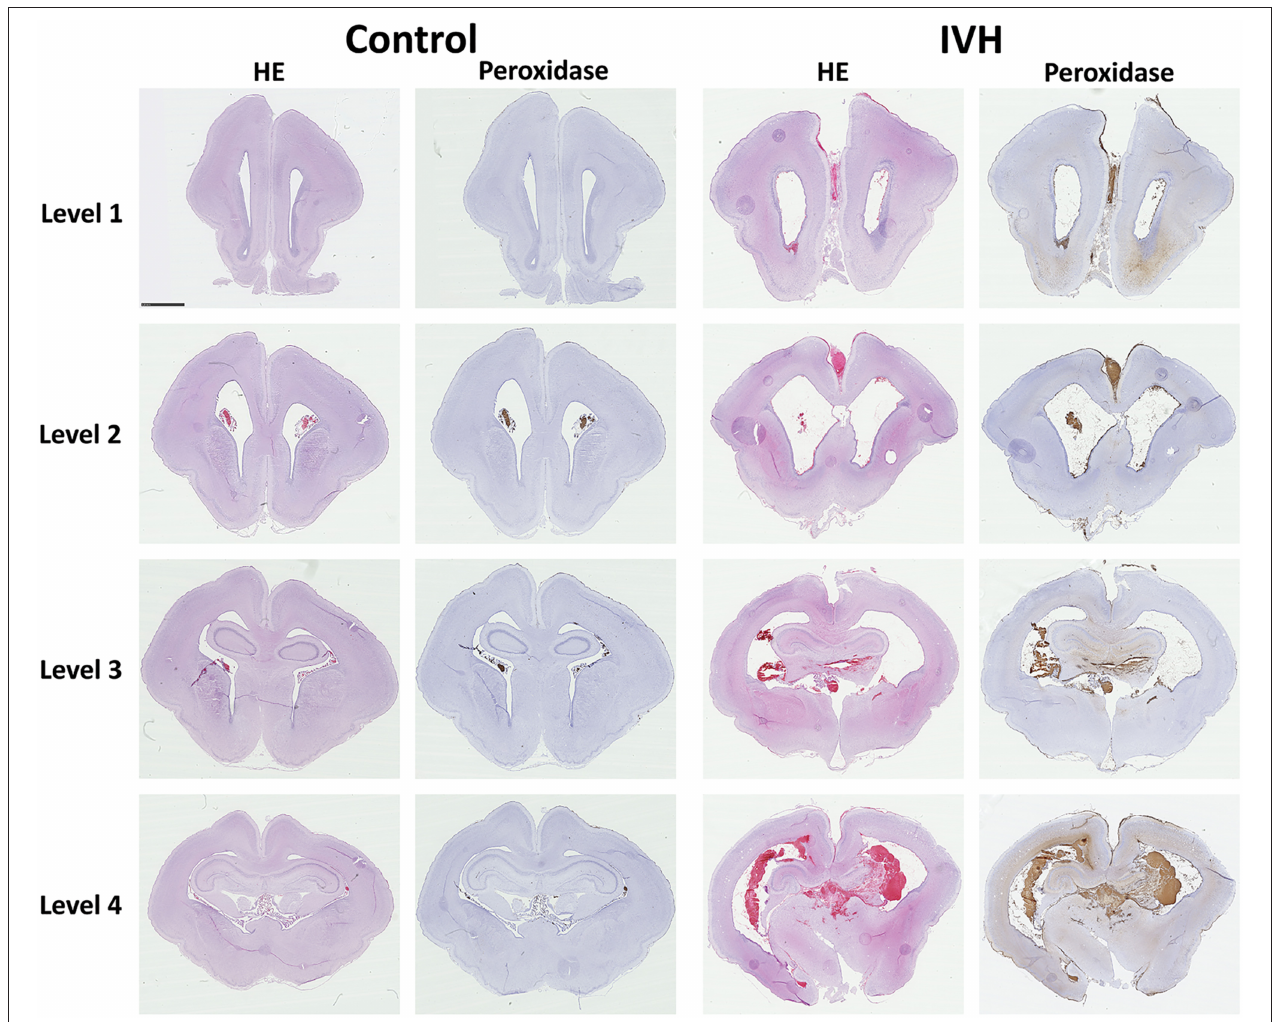
FIGURE 1 | Hemorrhage distribution following preterm rabbit pup IVH. Following IVH in preterm rabbit pups, the distribution of the hemorrhage was investigated. Rabbit pups with IVH or sham controls were euthanized at 72h of age followed by saline and freshly prepared 4% PFA perfusion. Afterwards the brains were dissected out from the skulls and immersed in 4% PFA. Brains were prepared and sections from Control and IVH animals, at the levels of rostral forebrain (Level 1), caudal forebrain (Level 2), rostral midbrain (Level 3) and caudal midbrain (Level 4), were stained for hematoxylin and eosin (HE) and peroxidase activity of Hb (Peroxidase) as described in the Materials and Methods Section. Microscope analyses were performed on a wide-field Olympus microscope (IX73) and slide scanning were performed on a Hamamatsu NanoZoomer 2.0-HT Digital slide scanner: C10730. Scanning was performed with a 40 × magnification lens. Scale bar indicate 2.5mm and is applicable for all